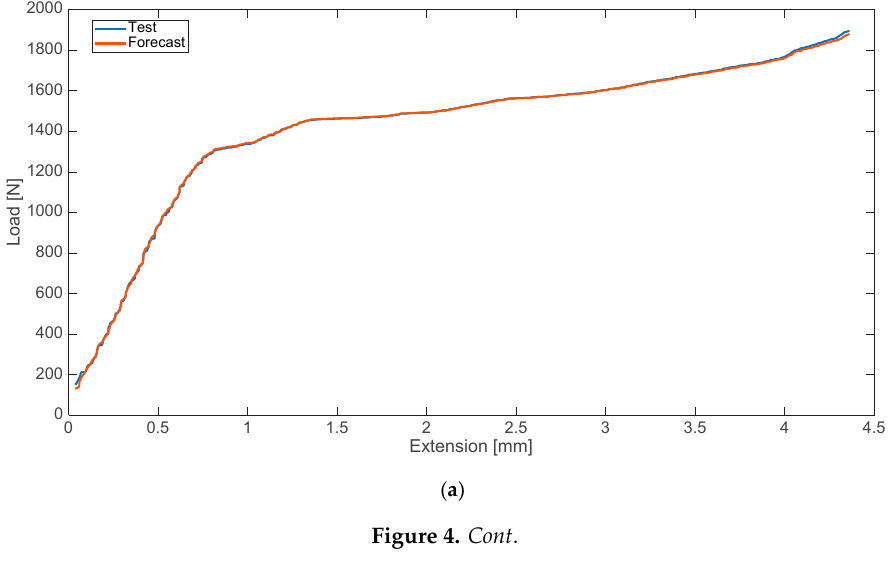
Figure 3. Strength characteristics ( a ) and error values ( b ) for 8% blood admixture.